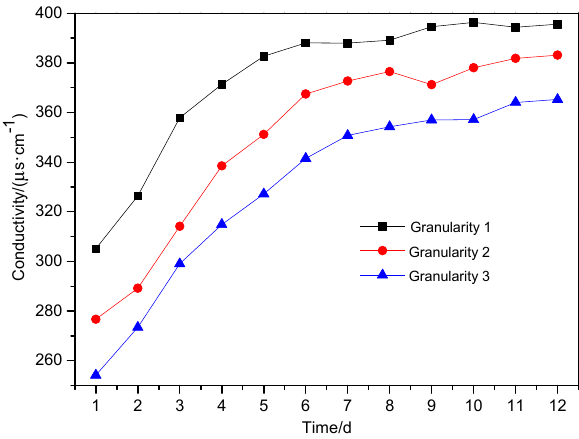
Figure 4. The trend in pH of leaching liquid over time with different particle size of waste.